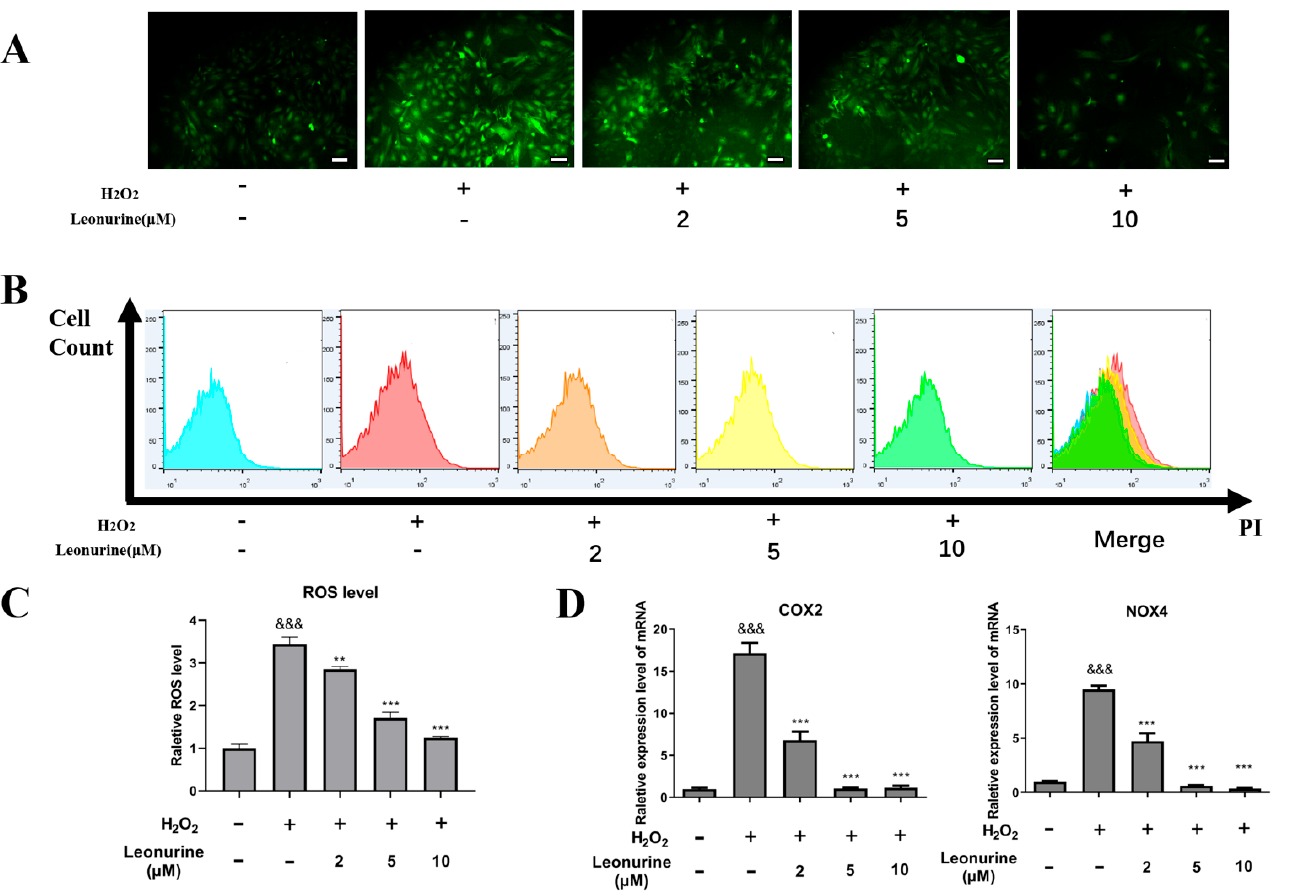
Figure 3. Effect of leonurine function on ameliorating ROS level. ( A ) Intracellular ROS measurement under microscopy (scale bar = 100 μ M). ( B ) Intracellular ROS measurement by flow cytometry. ( C ) Quantitative analysis of flow cytometry results. ( D ) Intracellular ROS-related marker expression level. &&& p < 0.001 vs. control group ** p < 0.01, *** p < 0.001 vs. H 2 O 2 group).